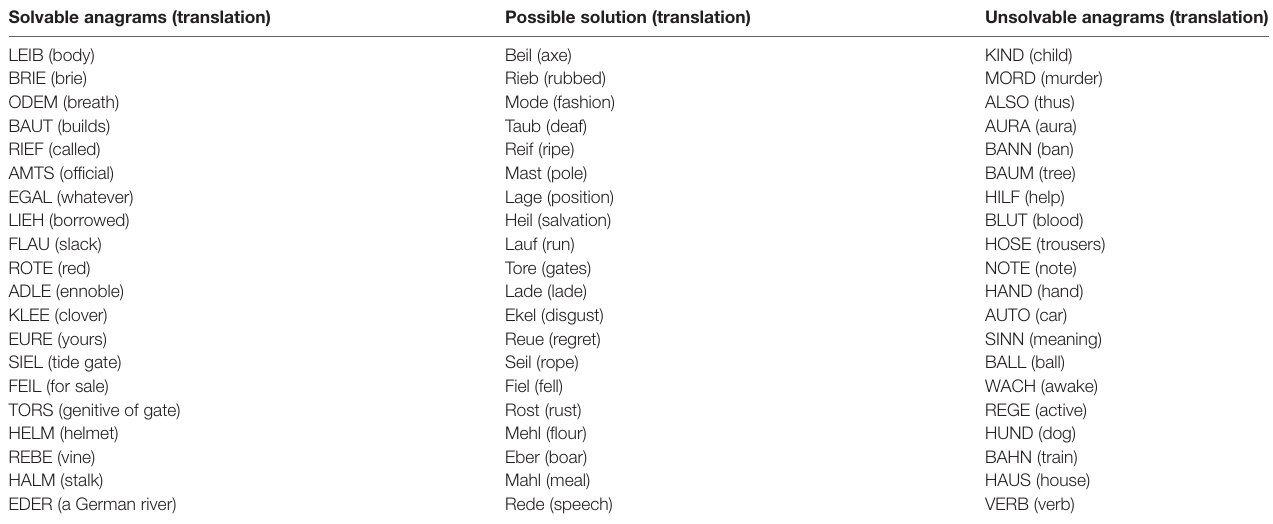
TABLE 1 | Solvable and unsolvable anagrams. Solvable anagrams